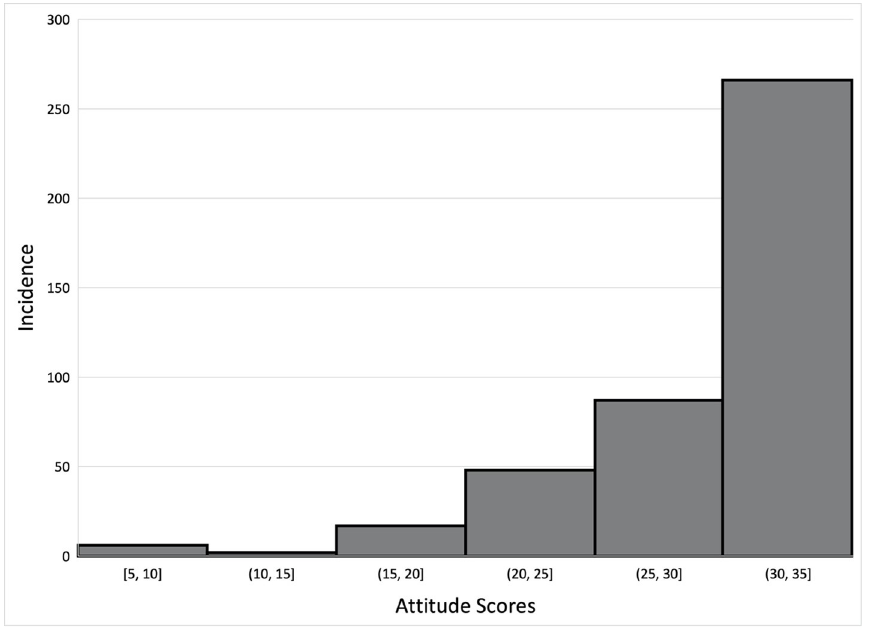
Fig 3. Distribution of attitude